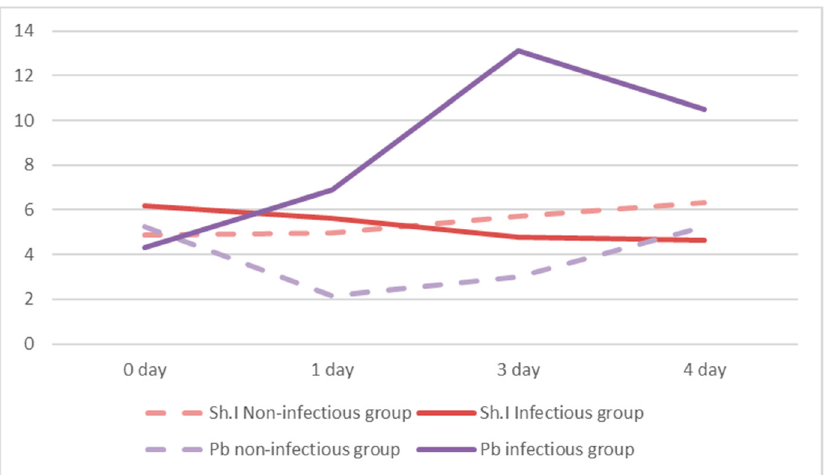
Figure A1. Heatmap of the temporal dynamics of the taxonomic composition of the intestinal microbiota in both infectious and non-infectious patient groups.